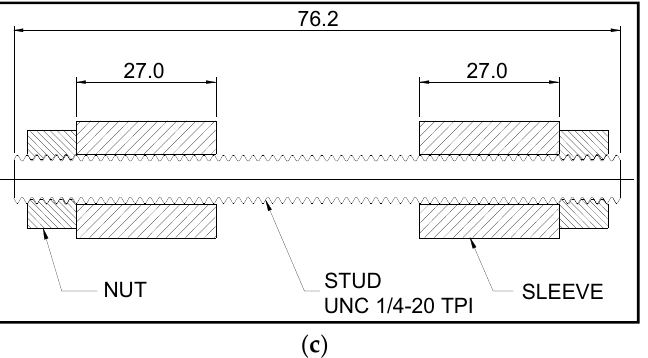
Figure 1. Detail of specimens used for testing. ( a ) Standard specimen according to ASTM E466, ( b ) threaded specimen 1/4”–20 TPI (dimensions in millimeter, except thread), ( c ) stud 1/4”–20 TPI specimen (with nut interface-dimensions in millimeters, except thread).